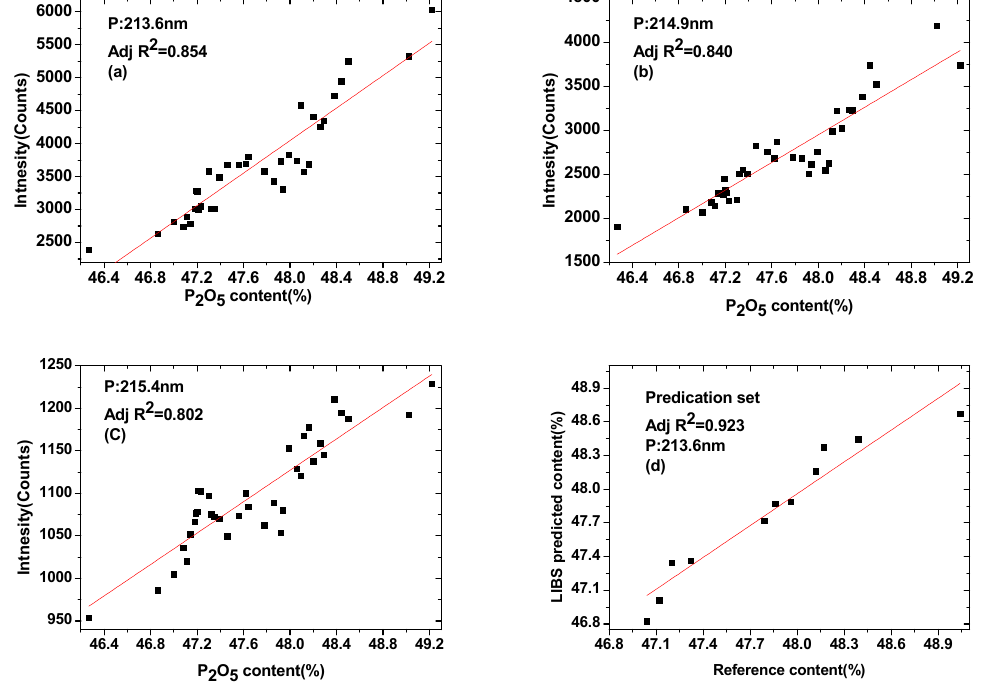
Figure 4. Calibration curves of P spectral line: ( a ) P: 213.6 nm, ( b ) P: 214.9 nm, ( c ) P: 215.4 nm, and ( d ) the relation of LIBS predicted value and reference value for the prediction set.